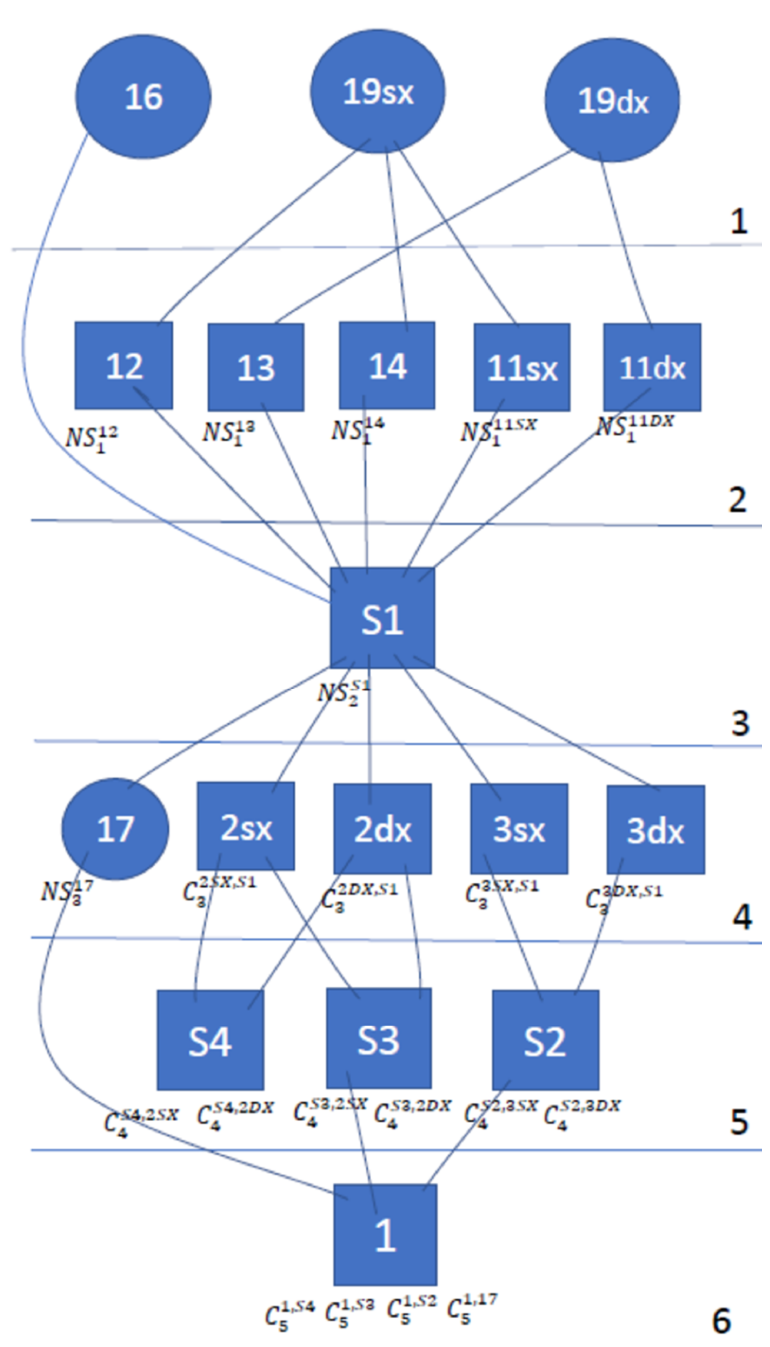
Figure 9. DGCG Figure 9. DGCG Graph.